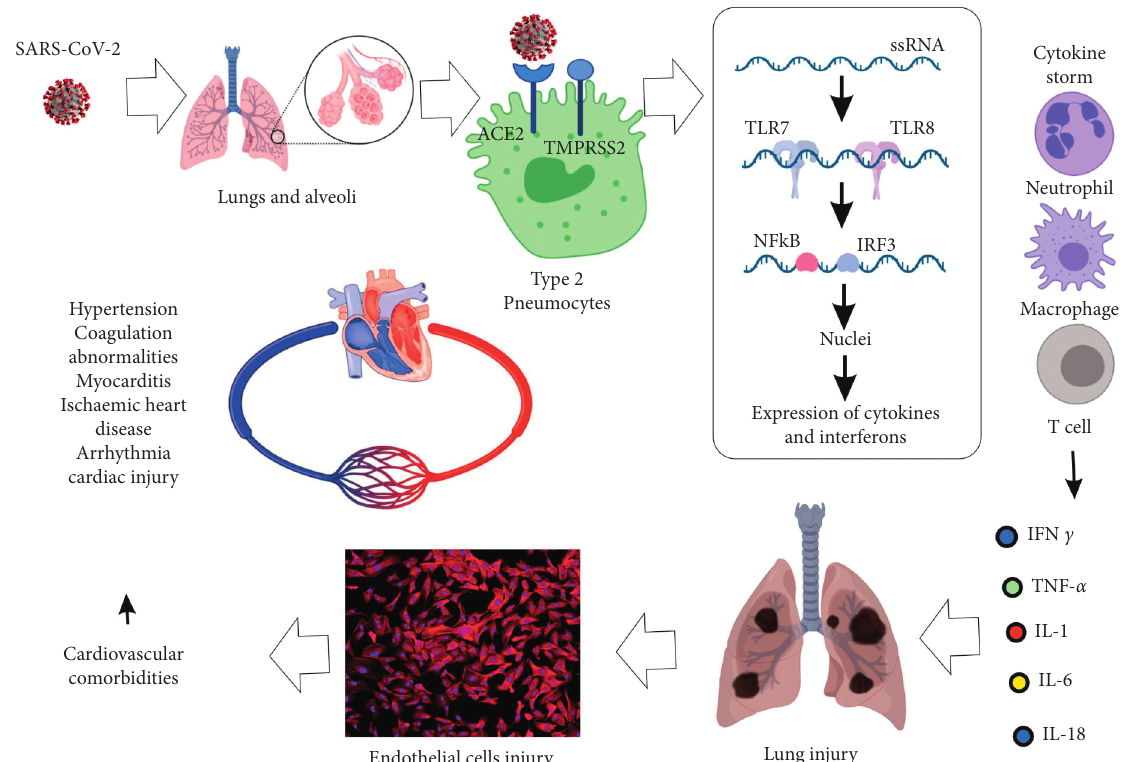
Figure 1: Progression of SARS-CoV-2 infection and the mechanisms implicated in the development of cardiovascular